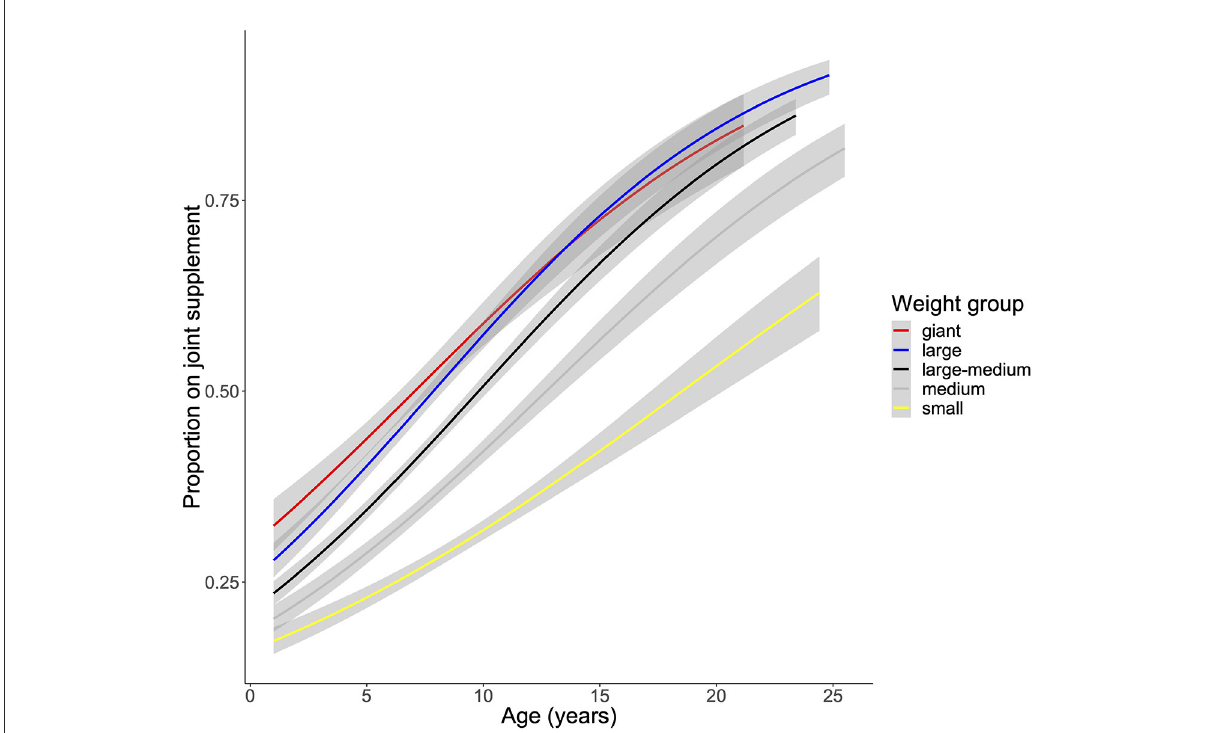
FIGURE1 Association of age and weight with joint supplement use in the Dog Aging Project cross sectional cohort. Age associations on joint supplement use were run with a logistic model for each weight class separately.